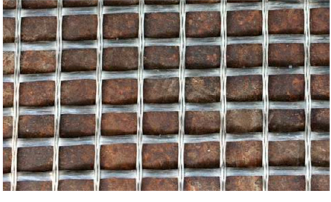
Figure 2. Alkali resistant glass fiber textile [40].